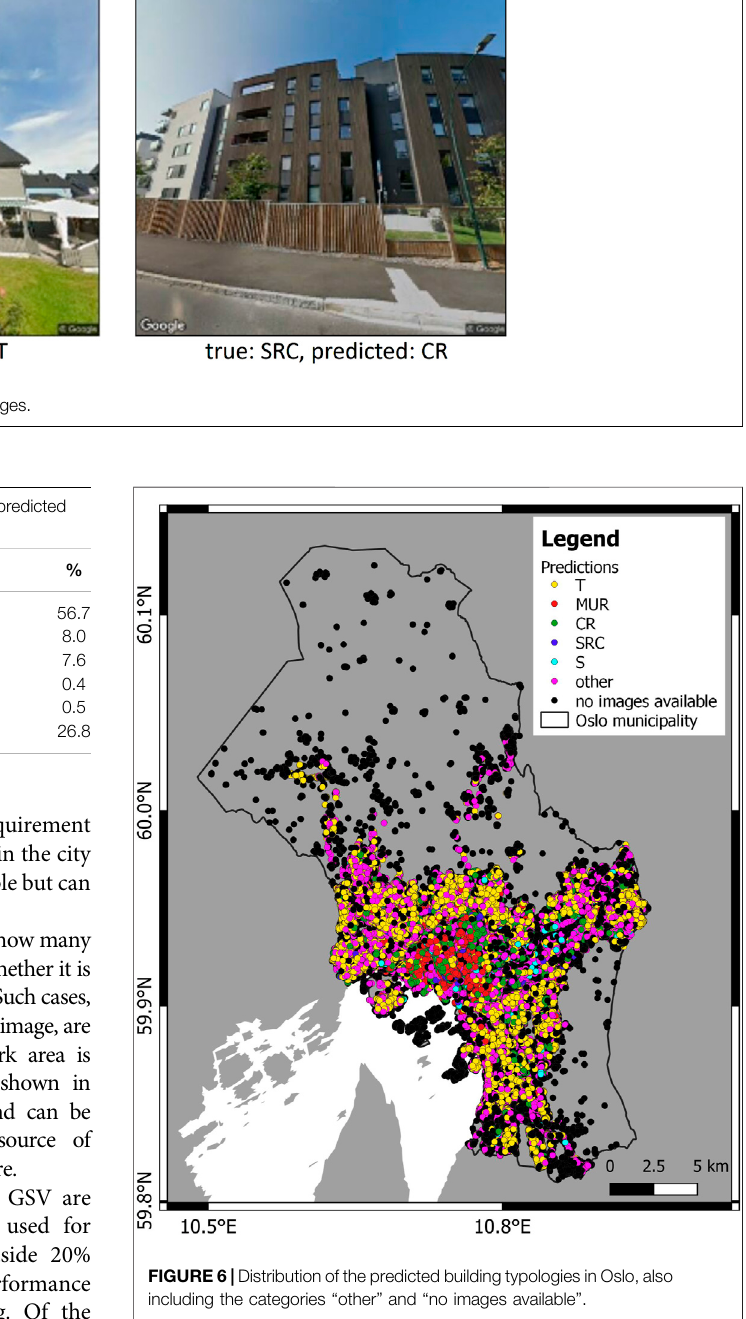
Frontiers in Earth Science |